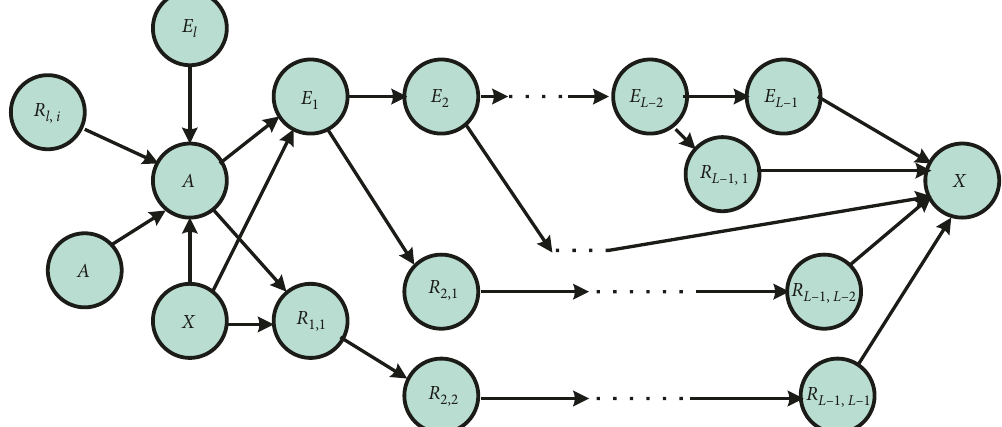
Figure 4: The DTMC model of ECS-HTCARQ protocol in an interference scenario.